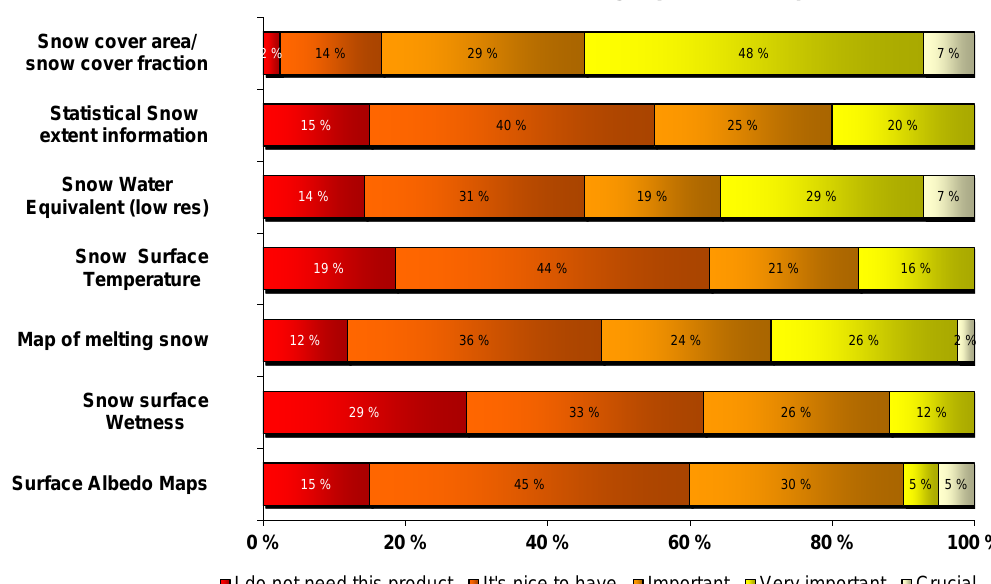
Figure 4. Relevance of snow products.